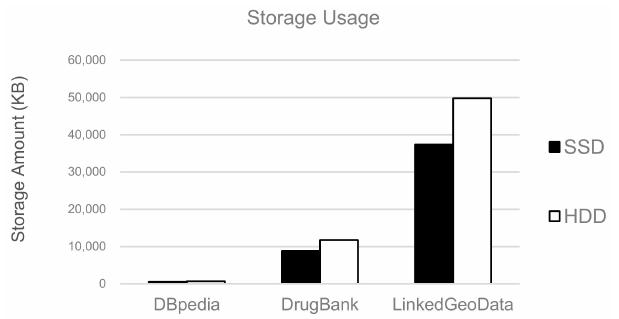
Figure 13. Results of relocating data in SSD and